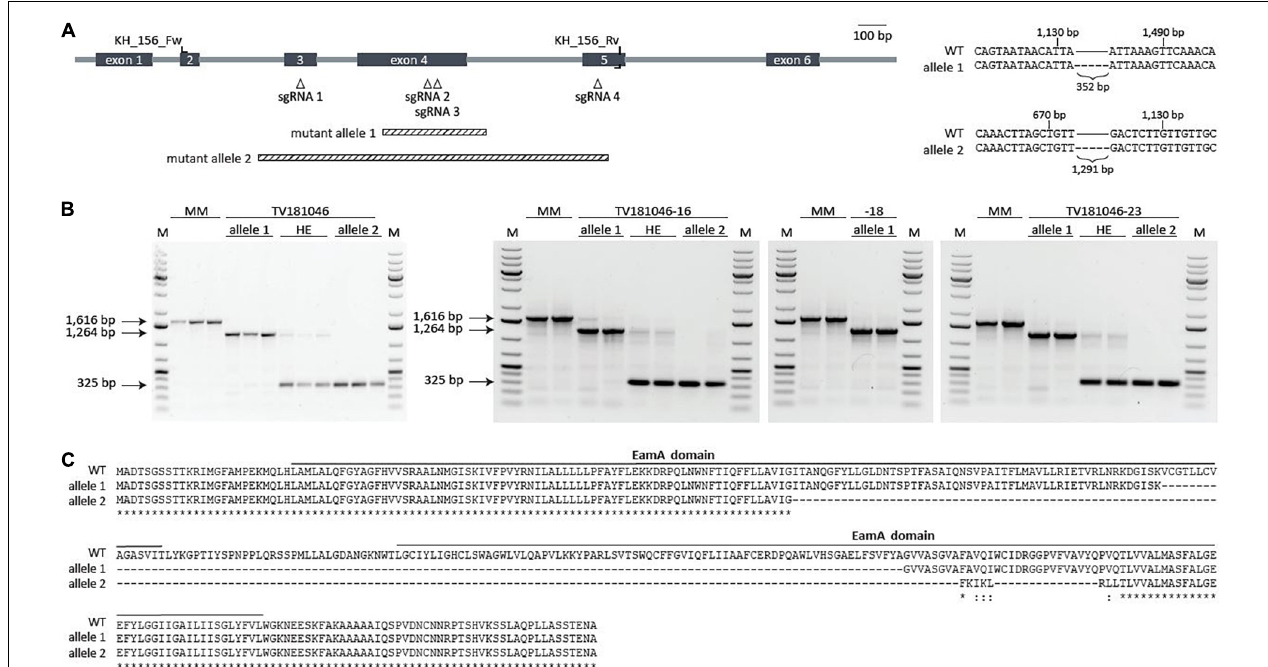
FIGURE 4 | CRISPR T2 family TV181046 and its T3 progeny carry a bi-allelic mutation in SlWAT1 . (A) Schematic overview of SlWAT1 (Solyc04g080940) indicating location of the sgRNAs, primers used for genotyping and the two mutant alleles (right). Sequencing revealed a 352 and 1,291 bp deletion for mutant alleles 1 and 2, respectively, compared with SlWAT1 wild-type (WT) (right). (B) Gel electrophoresis (1% TAE, ethidium bromide) of gene-specific PCR with (wild-type band at 1,616 bp) showing the two mutant alleles as well as heterozygous (HE) plants for the T2 (left) and the T3 (right) plants with a 1 kb ladder (M). (C) Protein alignments of SlWAT1 wild-type (WT) with mutant alleles 1 and 2 showing a 121 and 197 amino acid deletion, respectively. Mutant alleles were translated into protein using http://www.softberry.com/berry.phtml. CLUSTAL multiple sequence alignment was done using https://www.ebi.ac.uk/Tools/msa/muscle/. Solid bars indicate predicted protein domains annotated as EamA domain (https://www.ebi.ac.uk/interpro).